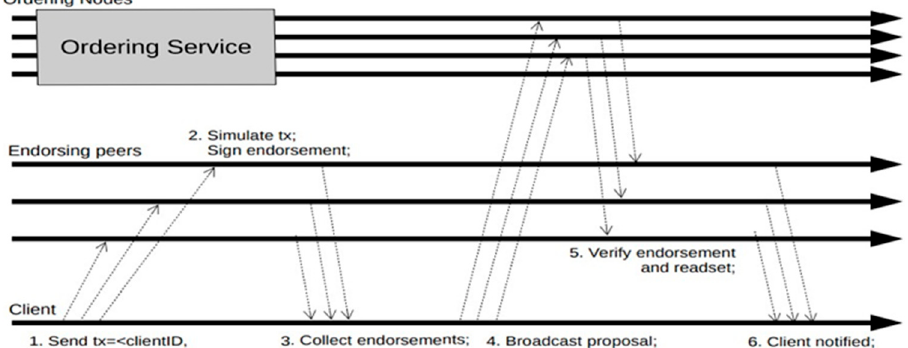
Figure 1. General overview of the Hyperledger fabric transaction process.